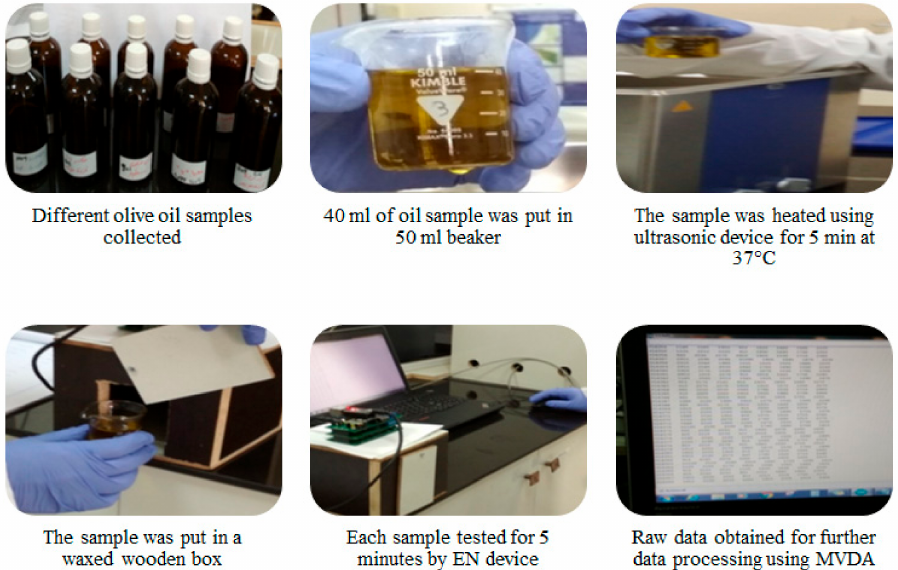
Figure 2. Steps for samples measurements by the electronic nose (EN) after chemical tests had been carried